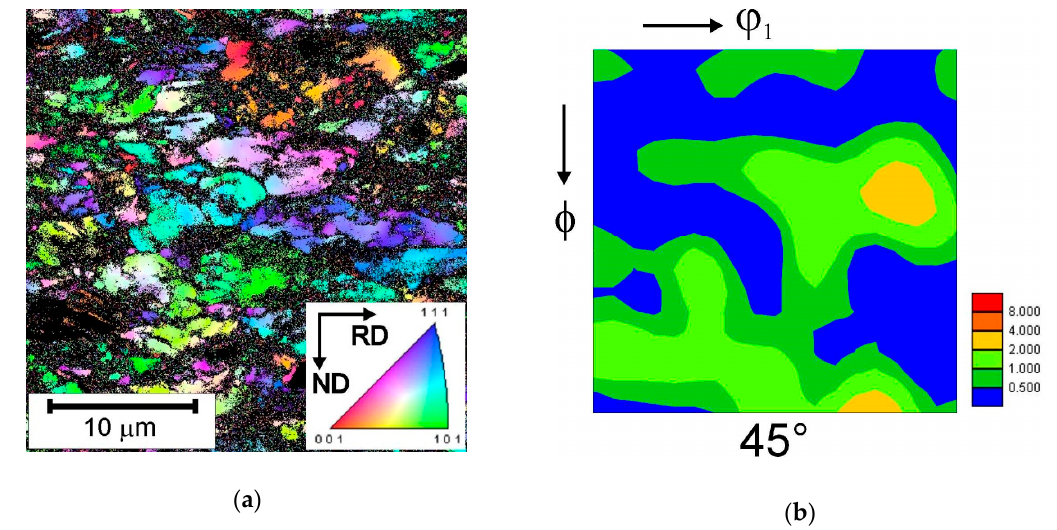
Figure 1. Microstructure ( a ) and orientation distribution function at ϕ 2 = 45 ° ( b ) of an Fe-0.4C-18Mn steel subjected to cold rolling. Colors in ( a ) correspond to crystallographic direction along the normal direction (ND).